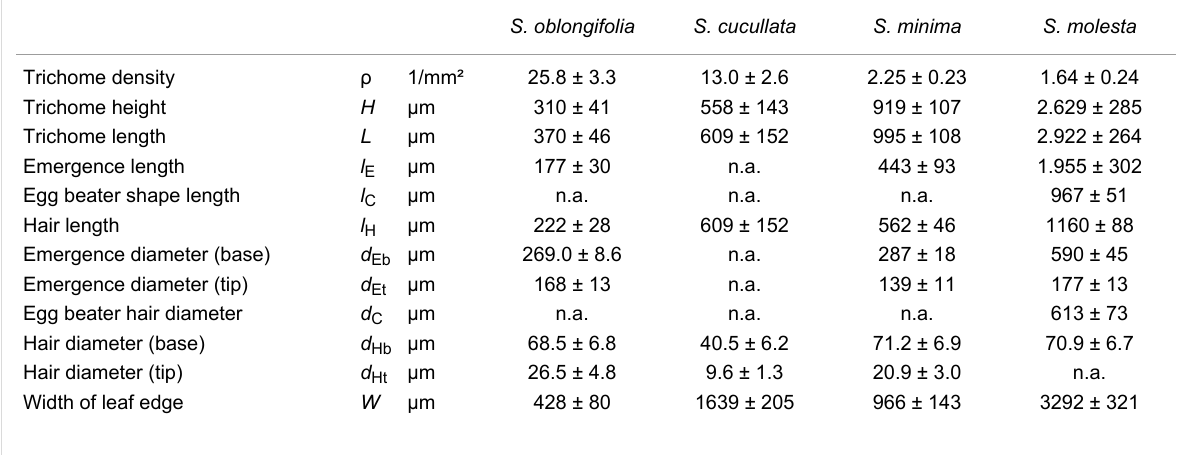
Table 1: Dimensions of characteristic trichome-parameters of four different Salvinia species (mean ± s.d., n = 10). For details see Figure